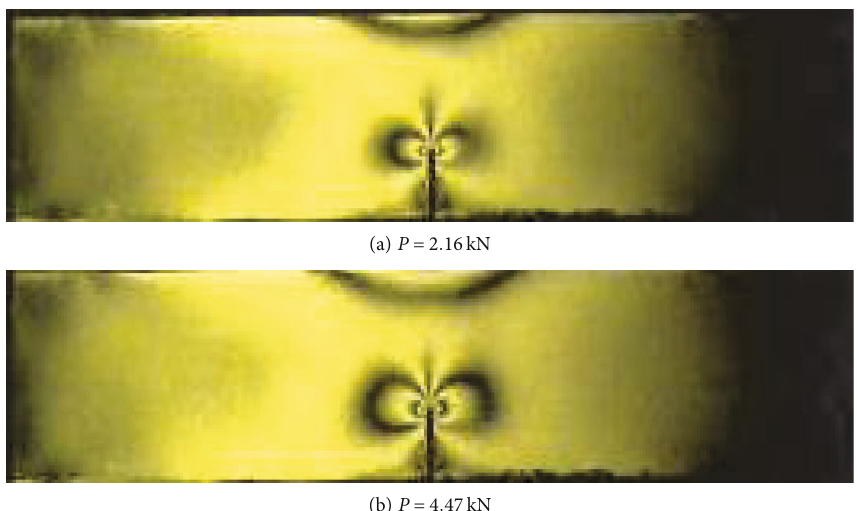
Figure 4: Crack propagation displayed by coatings (specimen